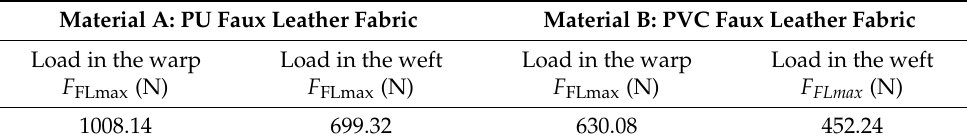
Table 1. Average values of unseamed fabric strength F FLmax (N).